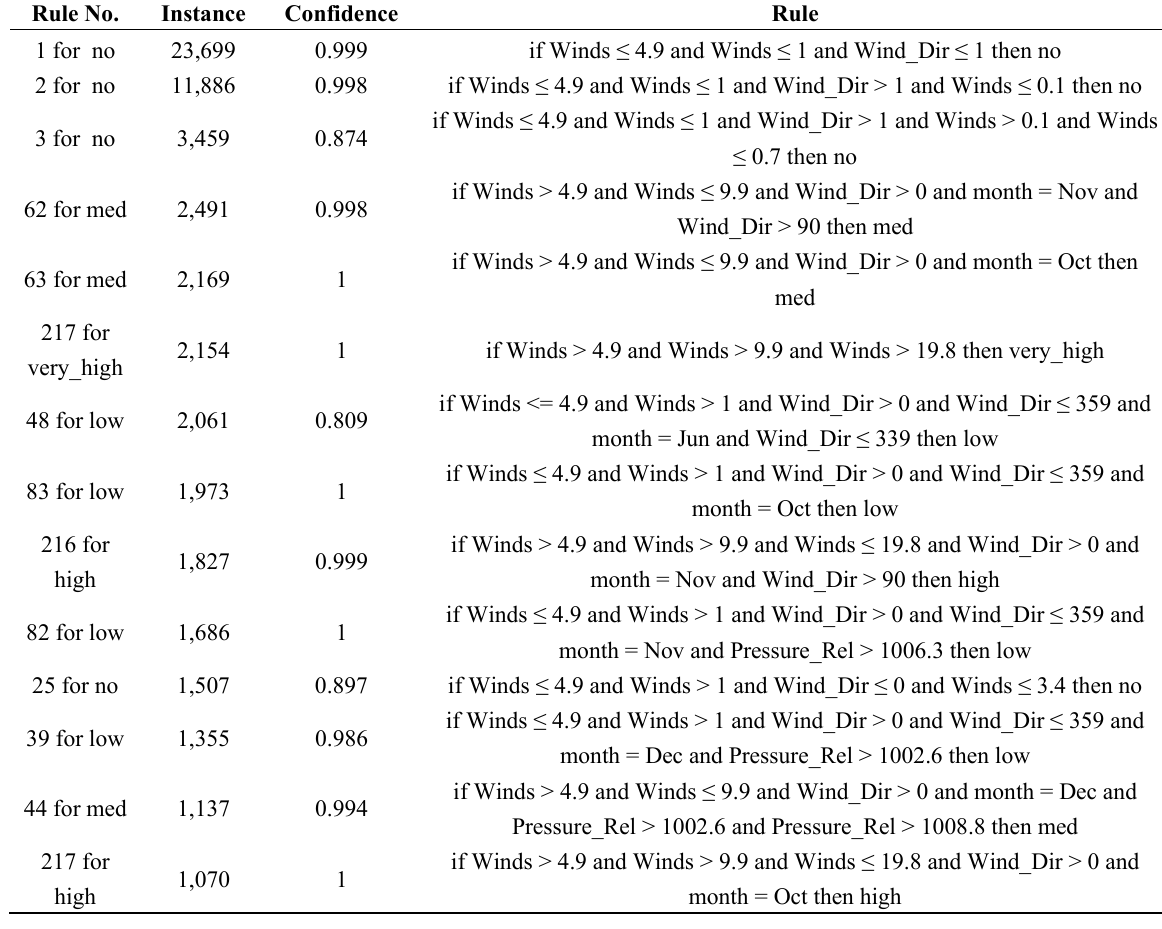
Table 4. Top 14 highest rules in terms of instances out of 847 rules produced by C5 algorithm for the 86,418 readings recorded at 5–30 min intervals. Gust values are converted into gust classes (no gust < 1, low < 3 medium < 10, high < 20 and very high > 20 km/h classes see Table 3 for